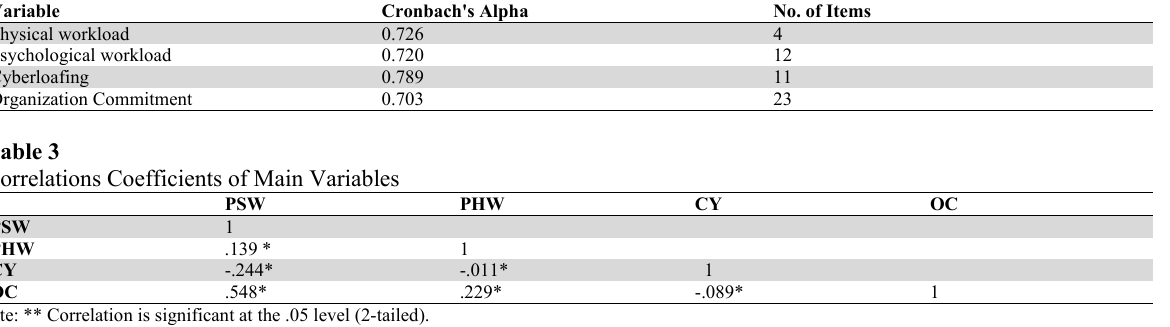
Reliability Analysis